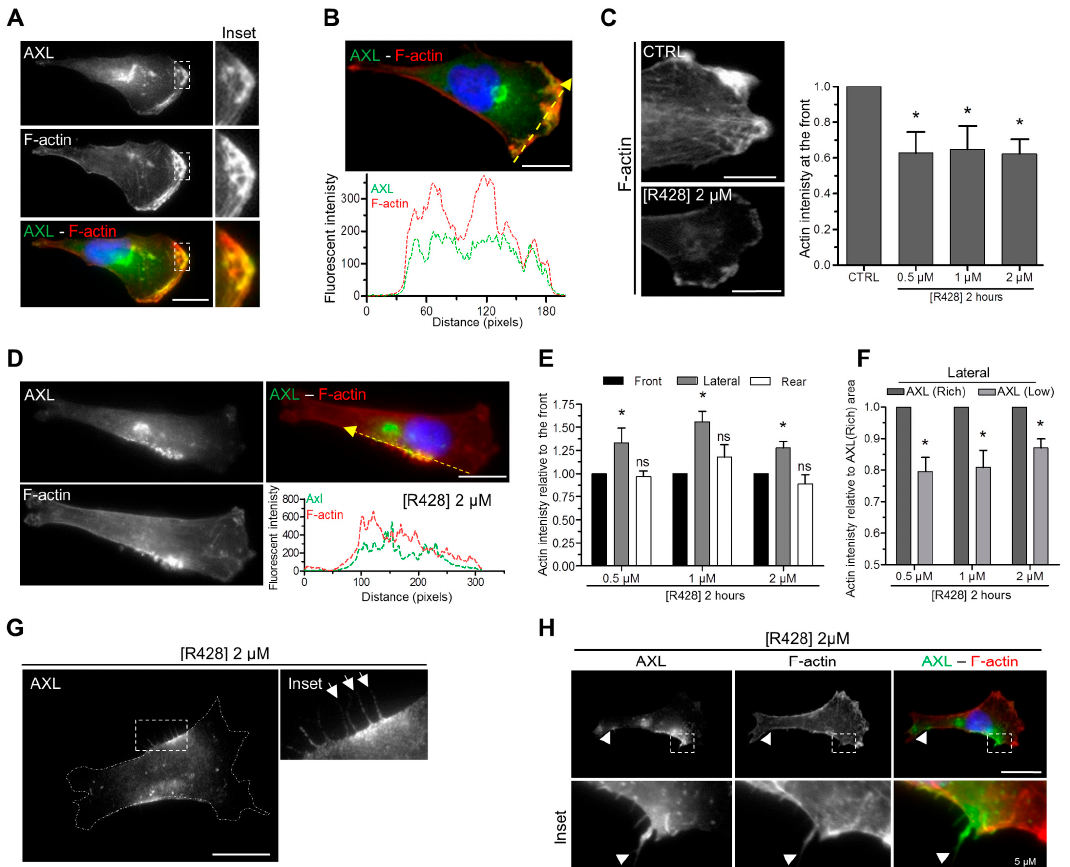
Figure 4. AXL inhibition leads to the loss of actin at the front of migrating cells and its enrichment at the lateral area where AXL relocalizes. ( A ) Hs578t cells stained for AXL (green) and F-actin (red). Inset focus on AXL and F-actin localization at the front of the cell. ( B ) Linescan of AXL (Green) and F-actin (Red) fluorescent intensity at the front of the cell (following the yellow dashed arrow on the top image). ( C ) F-actin intensity at the front of Hs578t cells treated with DMSO (CTRL) or with various concentrations (0.5, 1 and 2 µ M) of R428 obtained from 47, 30, 26 and 39 cells showing a relocalization of AXL at the lateral area in three independent experiments, respectively. (* p = 0.031; 0.043; 0.014). ( D ) Linescan of AXL and F-actin intensity at the lateral area of the Hs578t cell treated 2 h with 2 µ M R428 (following the yellow arrow on the top right image). ( E ) F-actin intensity at the front, at AXL enriched lateral area localization and at the rear of Hs578t cells treated with various concentrations (0.5, 1 and 2 µ M) of R428 obtained from respectively 27, 29 and 39 cells in three independent experiments. (ns > 0.05, * p = 0.042; 0.012; 0.023). F-actin intensity is normalized to the front to avoid intercellular heterogeneity. ( F ) F-actin intensity at the lateral area (AXL enriched side: AXL(Rich), AXL non-enriched: AXL(Low)) comprised between the front and the rear of Hs578t cells treated with various concentrations (0.5, 1 and 2 µ M) of R428 obtained from 27, 29 and 39 cells in three independent experiments, respectively. (* p = 0.015; 0.026; 0.016). ( G , H ) Representative images of AXL-rich cellular protrusions at the AXL enriched lateral area of Hs578t cells treated with 2 µ M R428 for 2 h. The cell is stained for AXL ( G ). The Cell is stained for AXL (Green) and F-actin (Red) ( H ). Arrowheads point to protrusions. Scale bars, 20 µ m unless otherwise specified. All graphs represent means and small bars indicate standard deviation.